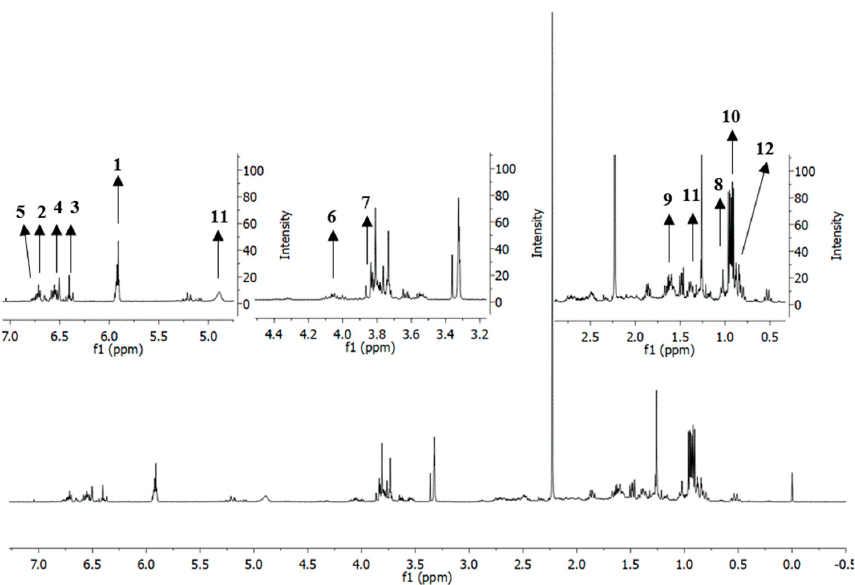
Figure 2. The representative 1 H-NMR spectrum of methanol extract of P. cubeba L. The numbers indicate the identified putative metabolites. 1 : cubebin; 2 : yatein; 3 : hinokinin; 4 : dihydrocubebin; 5 : dihydroclusin; 6 : cubebinin; 7 : magnosalin; 8 : p -cymene; 9 : piperidine; 10 : cubebol; 11 : D -germacrene;